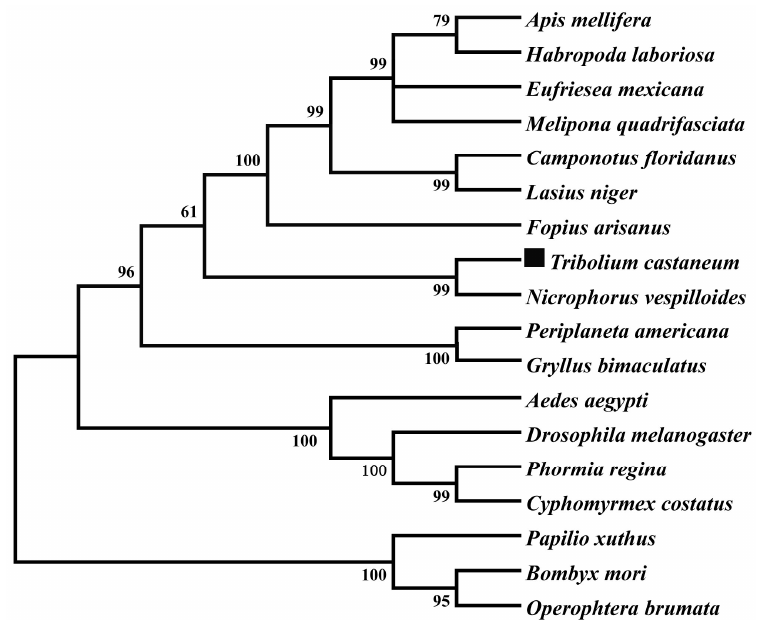
Figure 2. The phylogenetic tree of TcT β H (marked by black square) and various amino acids of the T β H neighbor-joining tree were constructed in MEGA 5 using 1000 bootstrap tests re-sampling. The numbers at the nodes of the branches represent the level of bootstrap support for each branch. The information on T β H in these spec i es is listed in Table S2.